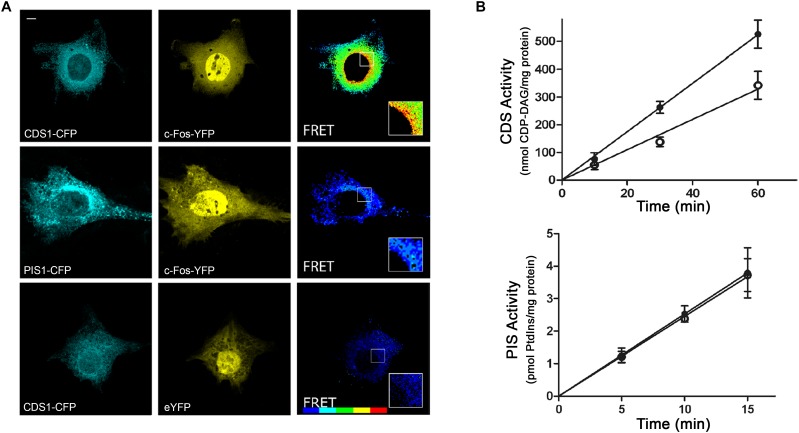
The enzyme CDP-diacylglycerol synthase (CDS) interacts with and is activated by c-Fos, while the enzyme phosphatidylinositol synthase (PIS) neither interacts nor is activated by c-Fos. (A) FRET experiments of cells co-transfected to express c-Fos-YFP and CDS1-CFP (first row) or PIS1-CFP (second row) were examined by confocal microscopy using filters for eCFP (left) or for eYFP (middle). FRET efficiency images were obtained and pseudocolored (right). The last row shows control cells co-expressing CDS1-CFP and eYFP. FRET scale goes from no FRET (blue) to maximum FRET (red). Scale bar: 5 μm. (B) Effect of c-Fos on CDS and PIS activities. Assays were performed in the presence (black circles) or the absence (open circles) of recombinant c-Fos. Formation of CDP-diacylglycerol (CDP-DAG) was measured in the case of determining CDS activity and phosphatidylinositol (PtdIns) in the case of examining PIS activity. Results are the mean ± SD of at least two experiments performed in triplicate. Adapted from Alfonso Pecchio et al., 2011 (article available to the public under an Attribution–Noncommercial–Share Alike 3.0 Unported Creative Commons License - http://creativecommons.org/licenses/by-nc-sa/3.0).